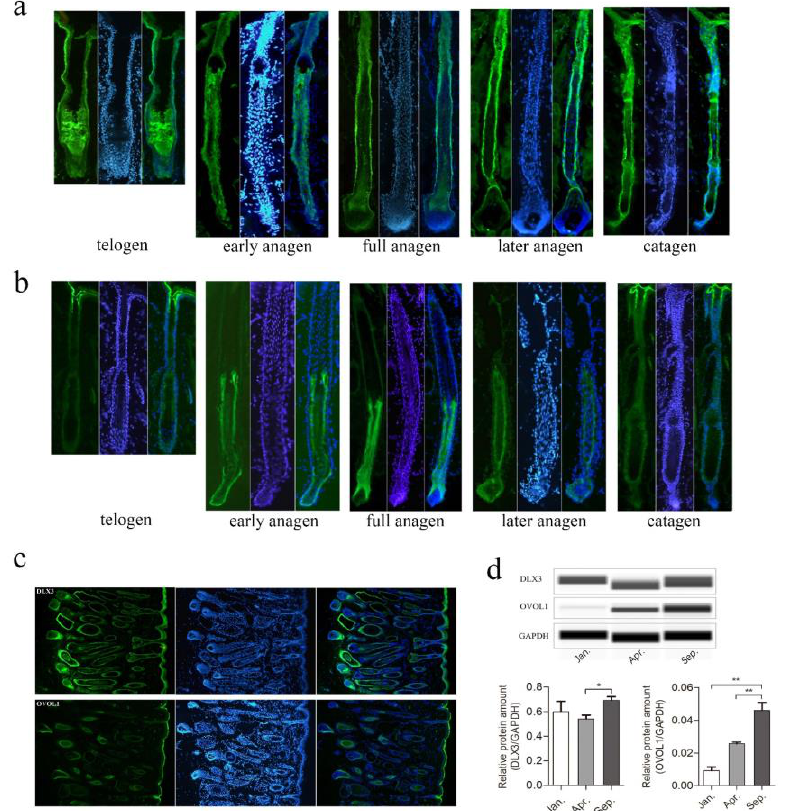
Figure 5. Detection of spatiotemporal expression of DLX3 and OVOL1 during yak HFs cycle by immunofluorescence. ( a , b ) The expressions of DLX3 ( a ) and OVOL1 ( b ) were detected using anti-Dlx3 and anti-Ovol1 antibody (green), respectively, in hair follicle at telogen, early anagen, full anagen, later anagen, and catagen. Staining in each period was represented by a single hair follicle—blue indicates DAPI staining. ( c ) Panoramic display of a microscope field in 10× of DLX3 (upper) and OVOL1 (lower) immunofluorescence staining. ( d ) Western blot analyses for DLX3 and OVOL1 protein levels in Jan. (catagen), Apr. (telogen), and Sep. (anagen), during yak HFs cycle, and the quantitative analysis of gray value were shown in histograms. Data are presented as mean ± SEM for 3 biological replicates; * p < 0.05; ** p < 0.01.